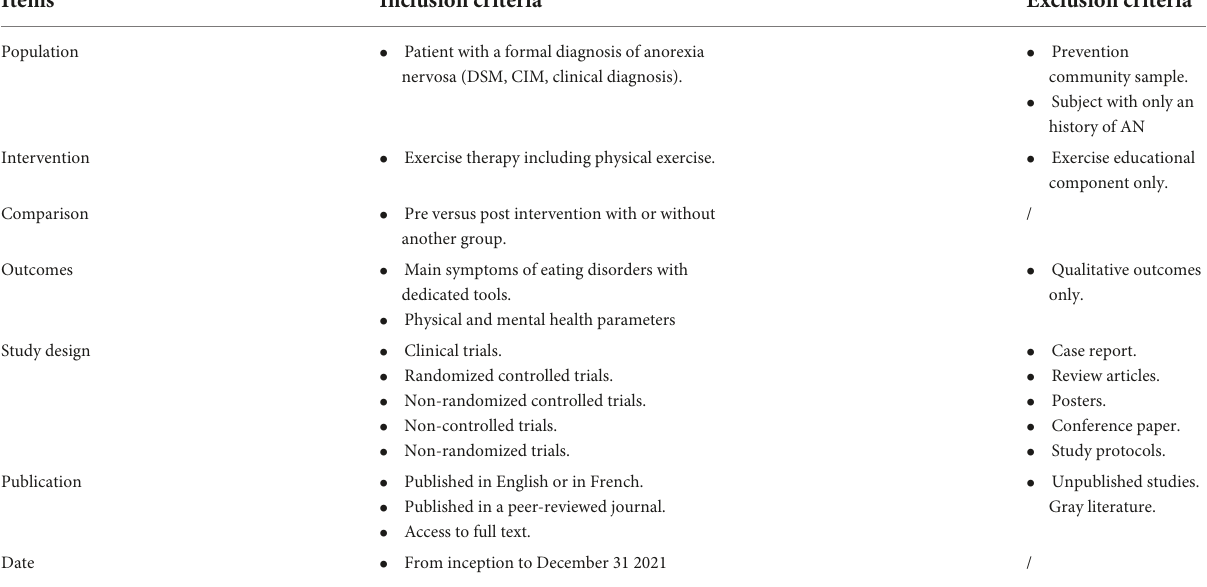
TABLE 1 PICOS (population, intervention, comparison and outcome), study design, publication and date criteria.